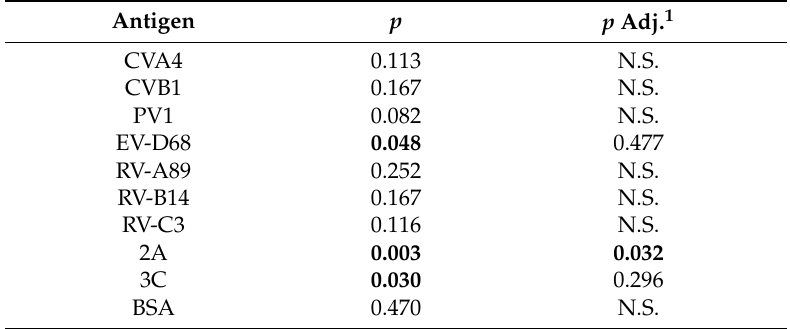
Table 2. Results of Wilcoxon rank-sum test between IgM positive and negative